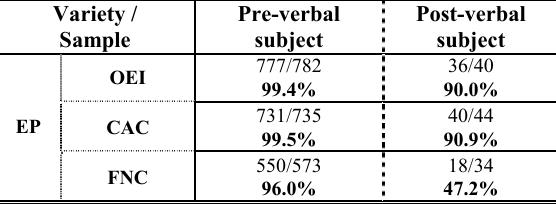
Table V: Third person plural verbal marking in EP and Subject position Variety